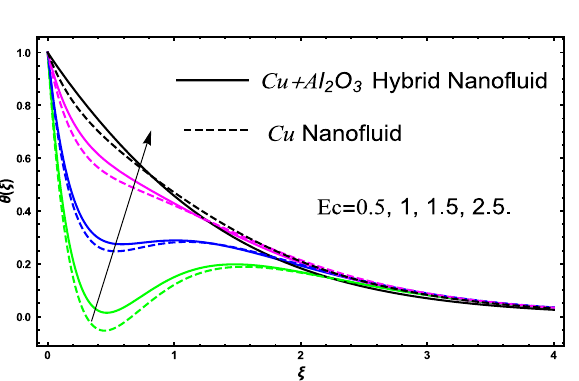
Figure 8. The fluctuation occur in temperature θ(ξ) versus large values of Ec .